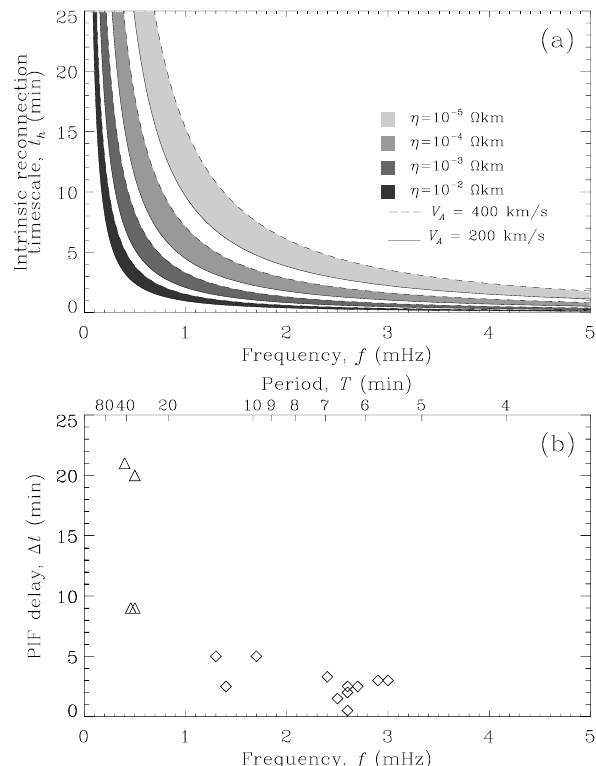
Fig. 9. (a) The intrinsic time scale for the onset of surface-wave induced magnetic reconnection (Uberoi et al., 1999) as a function of wave frequency with ka = 0 . 001, and for different values of magnetic resistivity η and Alfv´en velocity V A . (b) Observed delay of the PIF onset (ionospheric signature of reconnection onset) af- ter the IMF southward turning at the magnetopause for several PIF events. The delays are in addition to the Alfv´en propagation time between the magnetopause and the